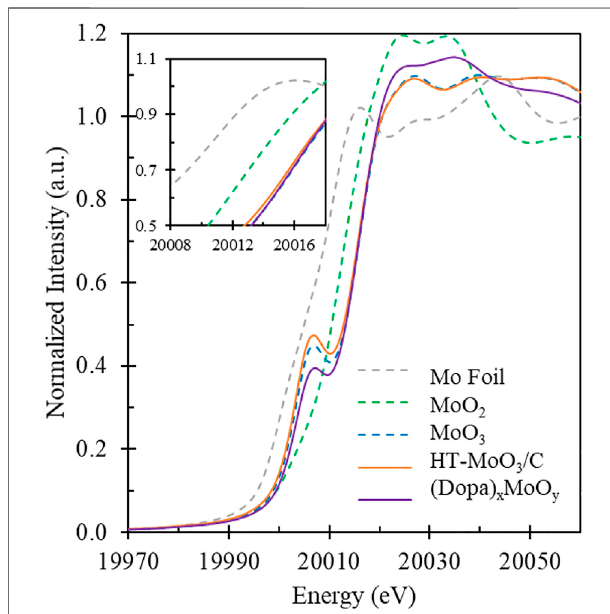
FIGURE 6 | Mo K-edge XANES spectra of (Dopa)xMoO 3 precursor and HT-MoO 3 /C samples next to Mo foil, MoO 2 and MoO 3 standards.